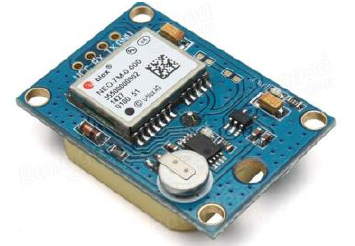
Fig. 6. GPS-NEO07 positioning